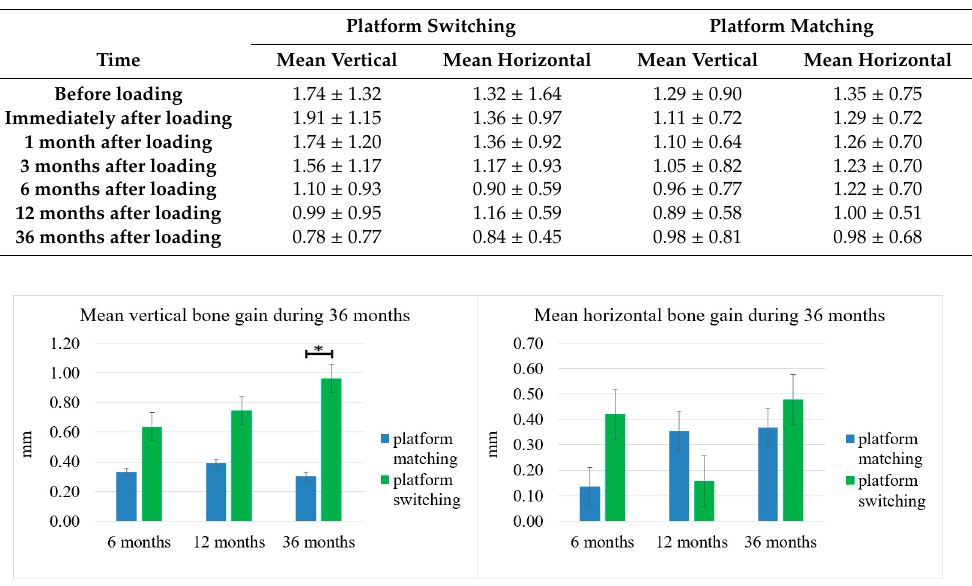
Figure 5. Mean vertical and horizontal bone gain at 6, 12, and 36 months, reported as standard error. Asterisks (*) indicate a statistically significant difference ( p < 0.05).